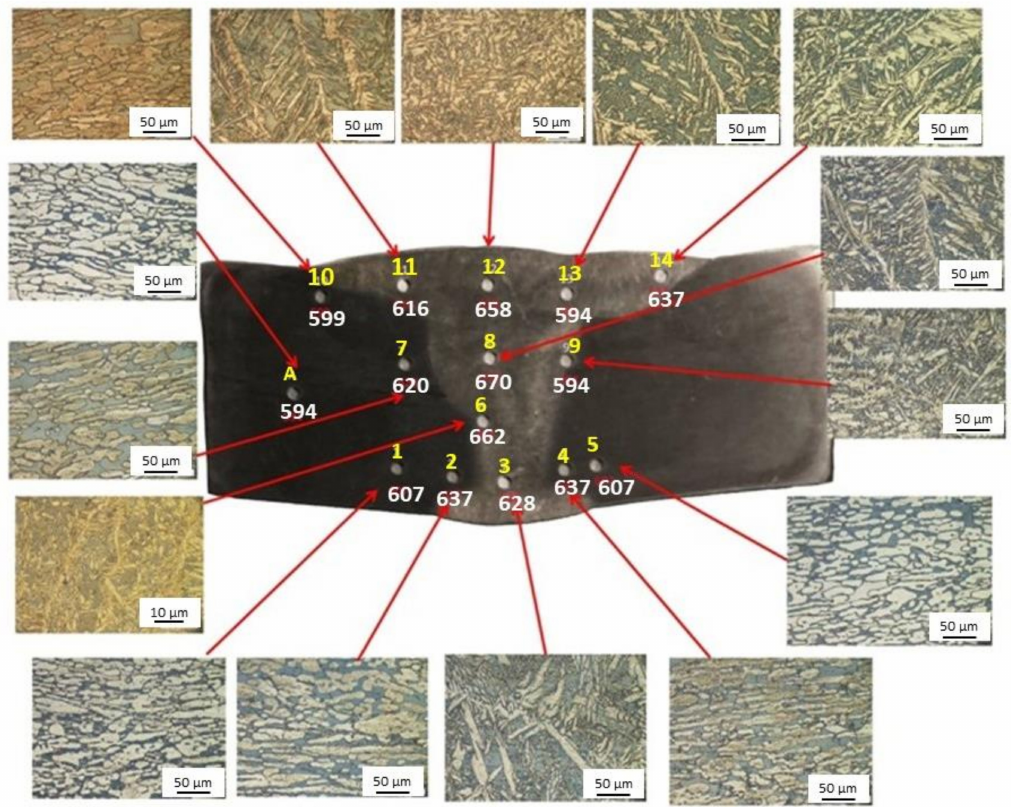
Figure 11. Local microstructure of the joint in areas close to the positions where 15 FIMEC indentation tests were performed (yellow). For each position, the P Y /3 values determined from FIMEC tests are reported (white). Table 4 reports the P Y /3 values determined by FIMEC tests and the average micro- hardness HV measured in the same